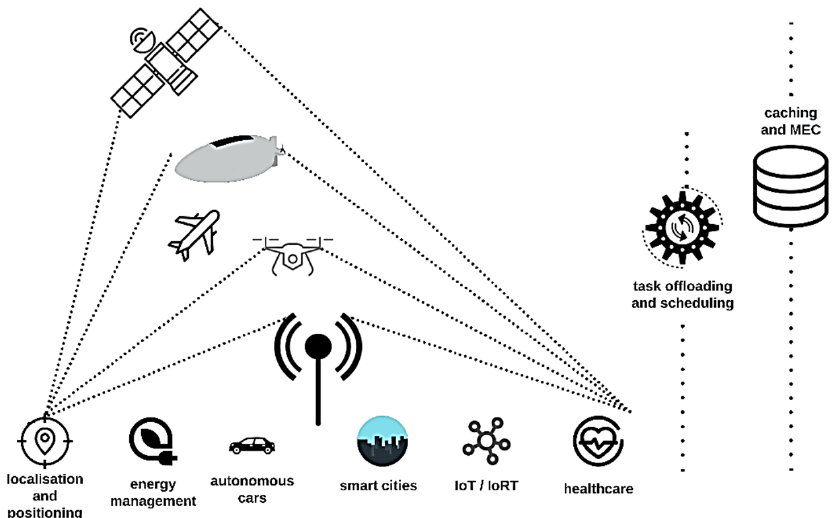
Figure 9. Common application scenarios by leveraging SAGINs and key services offered by the network infrastructure at different layers of the SAGIN.